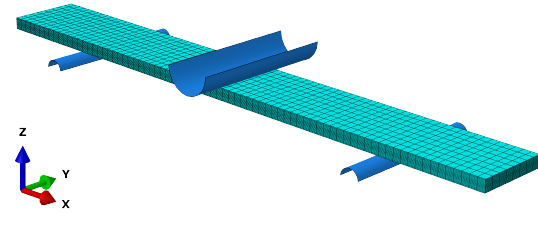
Figure 2. Finite element model of the 3PB test setup.